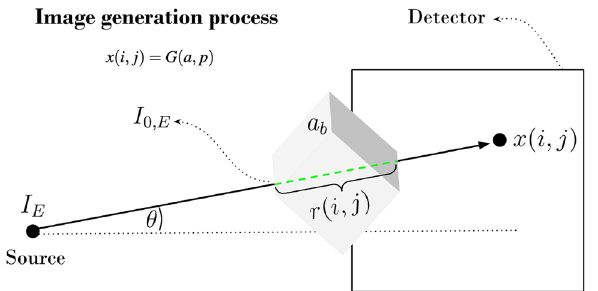
Figure 1. Physical description of the X-ray imaging generative process G ( a , p ) where a is the tissue of interest and p are the PIPs used for imaging of that tissue. The generated intensities (pixel values at positions ( i , j )) of image x ( i , j ) of breast b are strongly dependent not only on the human tissue a b imaged but also the values of the PIPs ( p b ) used for that particular breast. This framework extends to all anatomy. Technicians attempt to correct for variations in these images but still the variation is present 10 .This process is